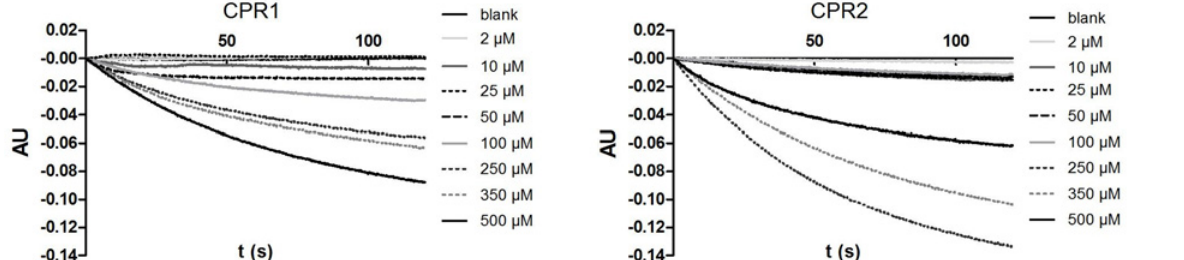
Fig 3. Standard plots for determining ferricyanide reduction kinetics catalyzed by Gs CPR1 or Gs CPR2 in the presence of NADPH. The CPR- catalyzed reduction of ferricyanide in concentrations between 2 μ M and 500 μ M at 420 nm in the presence of saturating 100 mM NADPH in 100 mM potassium phosphate (pH 7.6). Different concentrations of ferricyanide are represented in shades of grey and dashed lines. Decreasing absorbance at 420 nm, quantifying the reduction of ferricyanide to ferrocyanide, was plotted by normalizing all points relative to the point zero baseline.